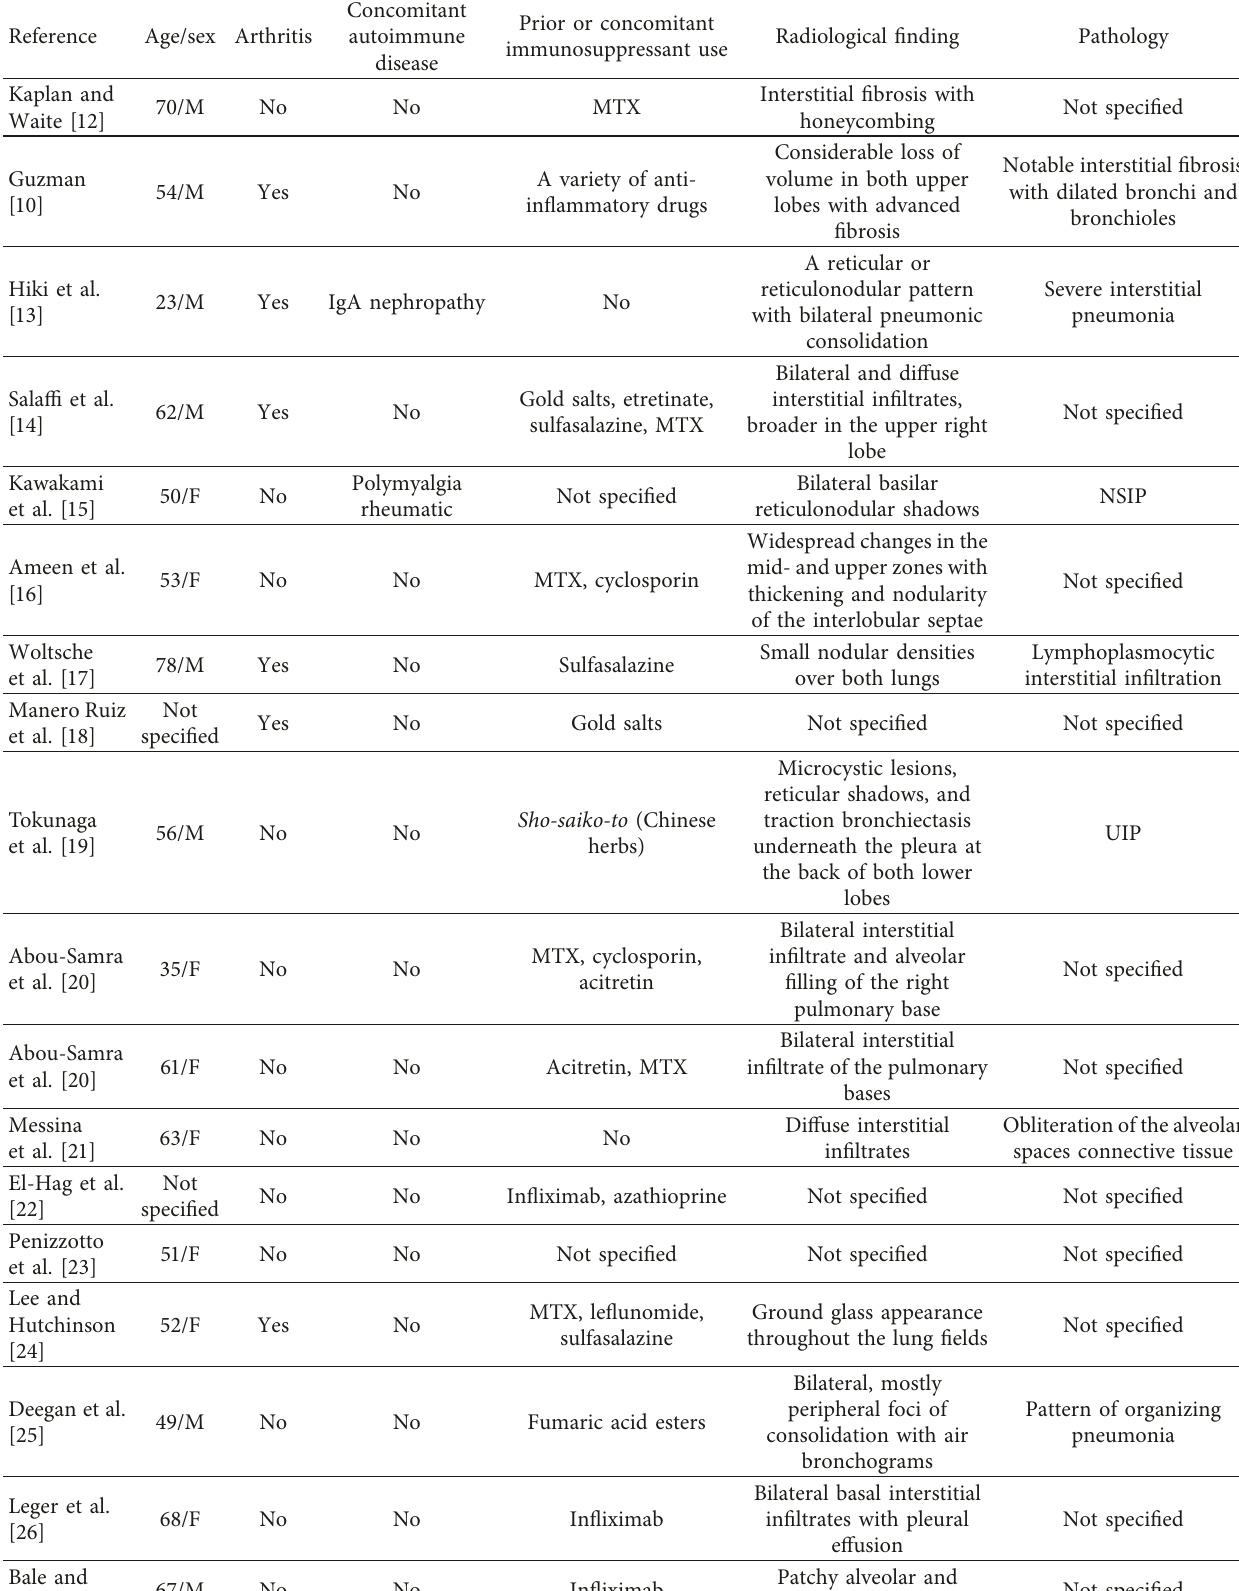
Table 3: Summary of previous reports on interstitial lung disease in conjunction with